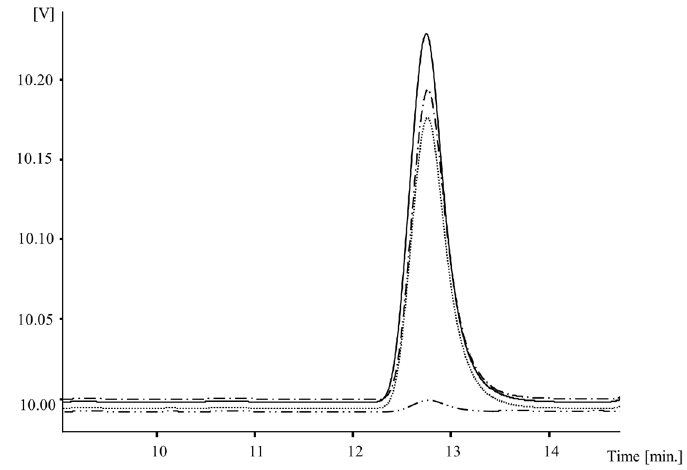
Figure 1. Vitamin D 2 -enriched extracts chromatogram profile of Agaricus bisporus Portobello (-), white A. bisporus (.-.-) and Pleurotus ostreatus (...) irradiated with UV-C (6 min at 3200 mJ/cm 2 ), and A. bisporus Portobello control samples (..-..-).